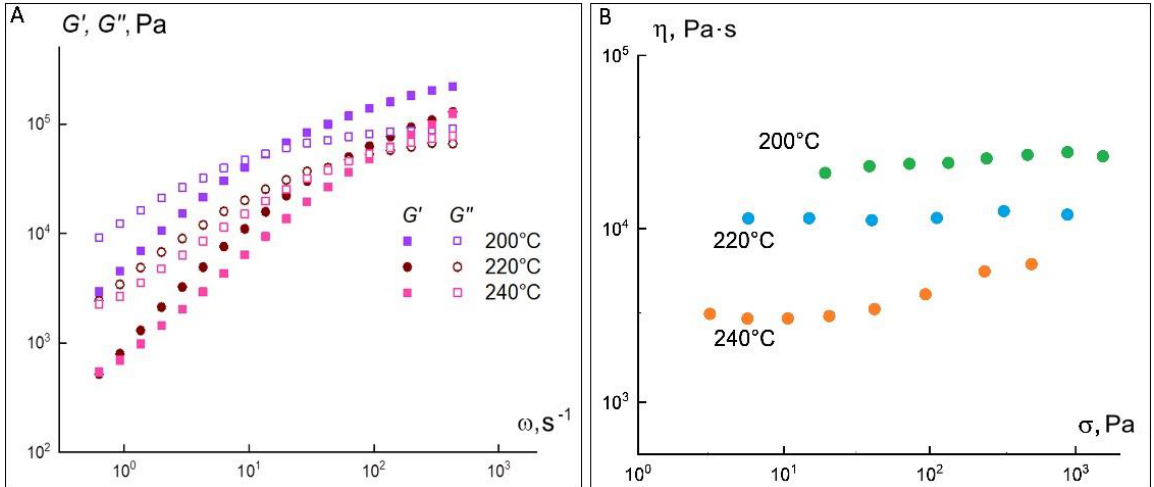
Figure 9. Frequency dependences of elastic and loss moduli ( A ) and viscosity versus shear stress for the 60Al 2 O 3 /40PLA composition at different temperatures ( B ).